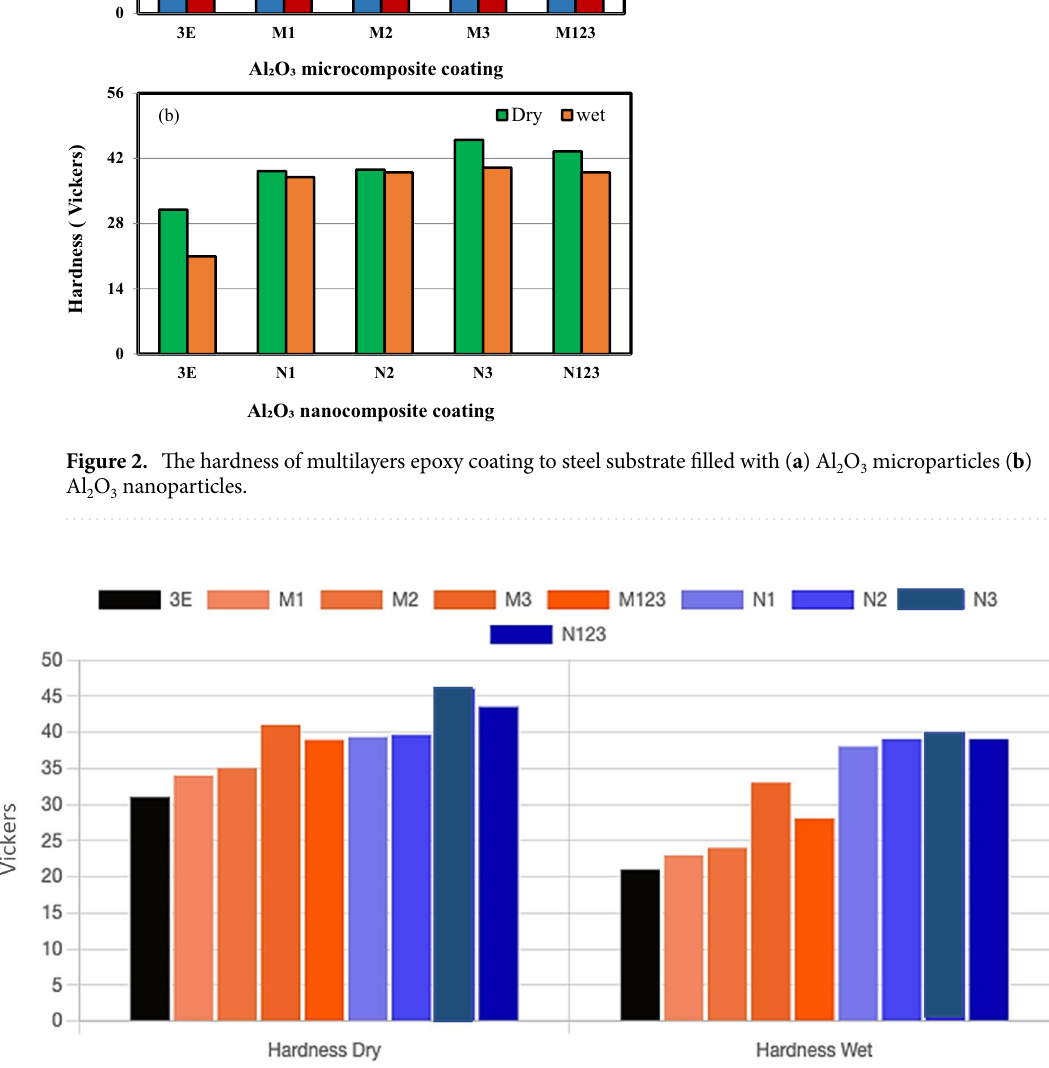
Figure 3. A comparison between the hardness values of microcomposite and nanocomposite coating under dry and wet